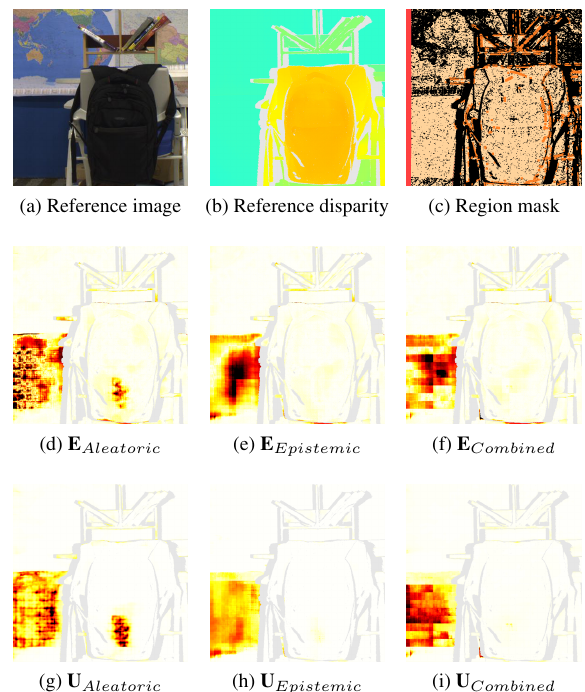
Figure 3. Qualitative comparison of different variants of the method proposed on an example of the InStereo2K dataset. The figure shows the absolute disparity error maps E in compar- ison to the associated uncertainty maps U of the three variants that estimate aleatoric, epistemic and both kinds of uncertainty together, respectively. In both the error and the uncertainty maps, small values are shown in white, large ones in dark red / black. Note that the values of the three uncertainty maps are scaled to the same interval to allow for an easier comparison. The refer- ence disparity map shows large disparities in orange to red and small ones in turquoise to dark blue. The region mask highlights regions that are especially challenging in the context of dense ste- reo matching, showing weakly textured areas in beige, occluded areas in red and pixels close to depth discontinuities in